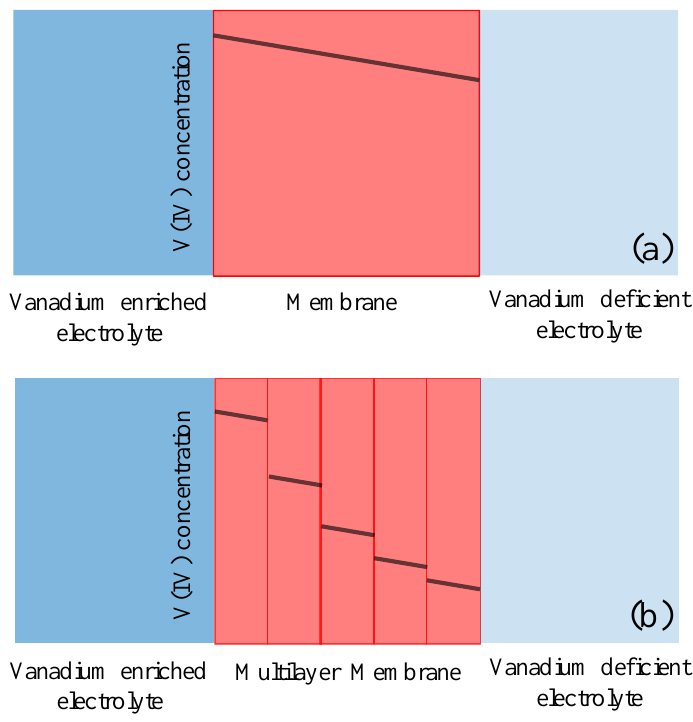
Figure 12. Schematic illustration of proposed reduction of ionic crossover for multilayers of IEMs, ( a ) 1 layer of N115, ( b ) 5 layers of NR211.